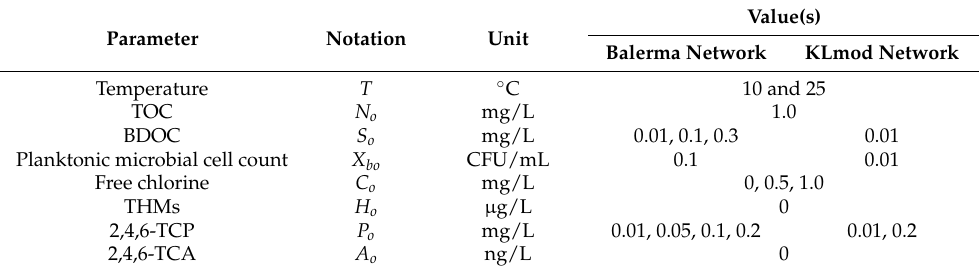
Table 3. Test conditions considered for conducting